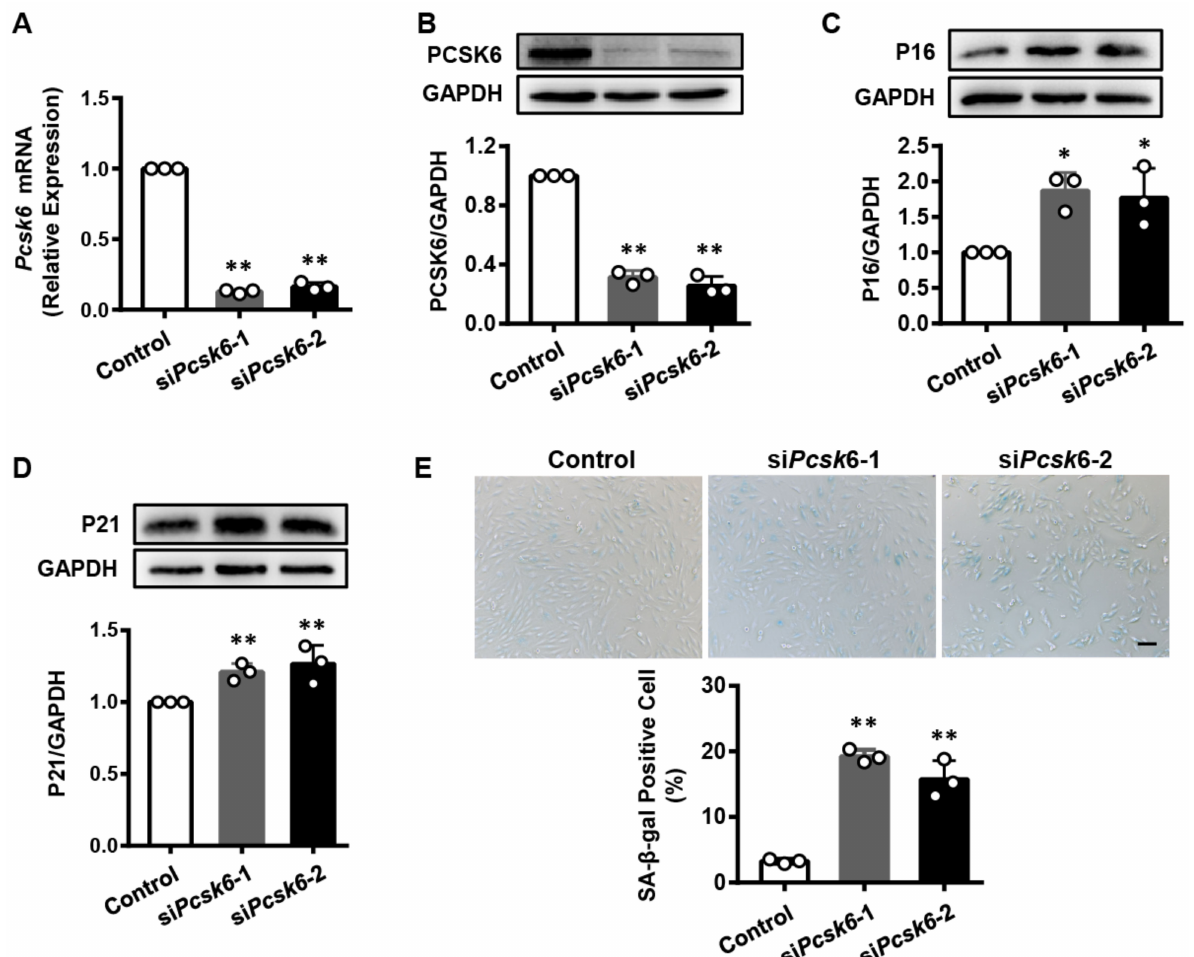
Figure 3. Increased cardiomyocyte senescence by Pcsk6 knockdown. ( A ) Pcsk6 mRNA expression in H9c2 cells treated with two sets of siRNAs targeting rat Pcsk6 gene (si Pcsk6 -1 and si Pcsk6 -2) was estimated by qPCR. ( B ) PCSK6 protein expression in si Pcsk6 -transfected H9c2 cells was analyzed by densitometric quantification of Western blotting. ( C , D ) Western blot analysis of P16 and P21 protein levels in si Pcsk6 -transfected H9c2 cells. ( E ) SA- β -gal staining in si Pcsk6 -transfected H9c2 cells and quantitative data for SA- β -gal-positive cells. Scale bar: 100 µ m. Data are means ± S.D. * p < 0.05, ** p < 0.01 vs.